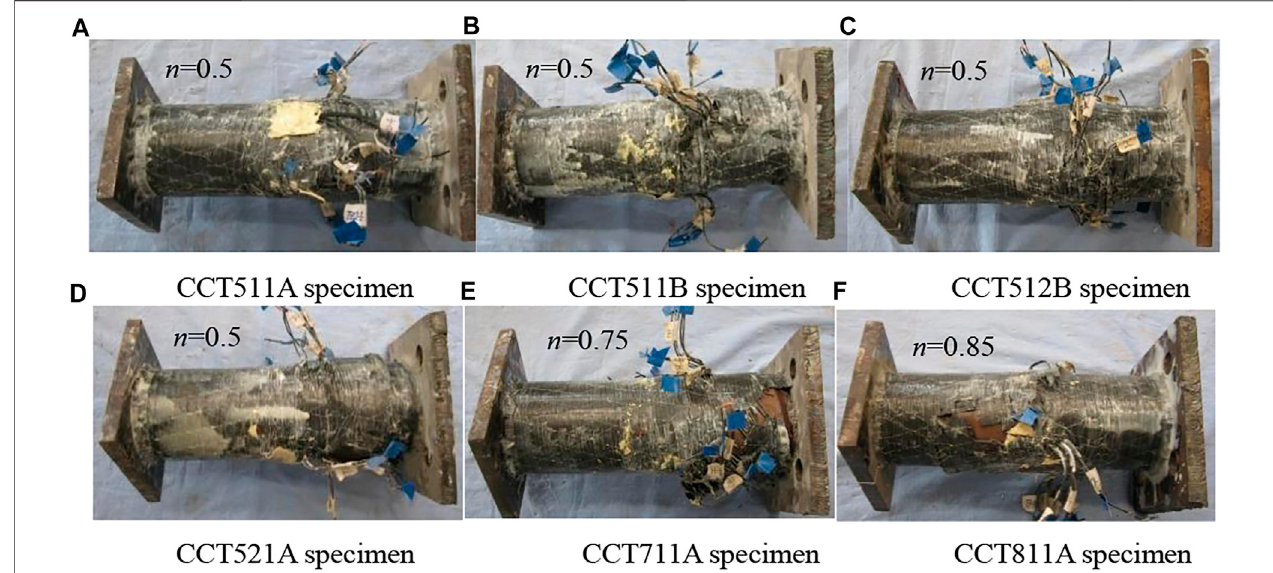
Frontiers in Materials |